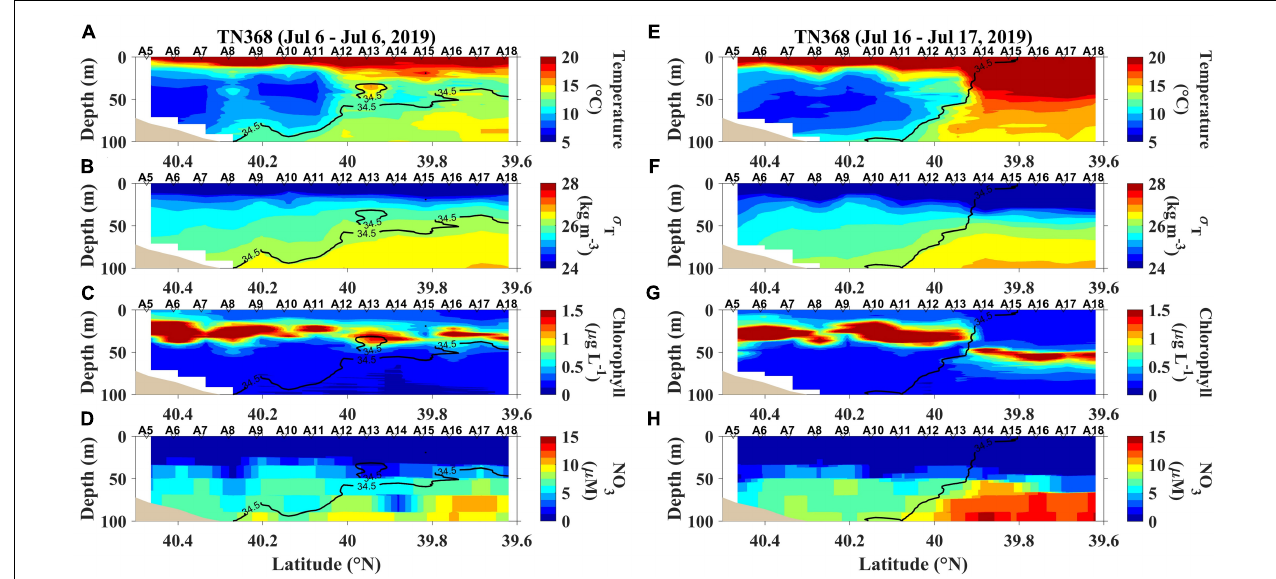
FIGURE 4 | The first and last section occupied during TN368; (A) temperature, (B) density (expressed as σ T ), (C) chlorophyll and (D) nitrate concentrations (NO 3 ) sampled on July 6, 2019, and (E) temperature, (F) density (expressed as σ T ), (G) chlorophyll and (H) nitrate concentrations (NO 3 ) sampled from July 16–17, 2019.